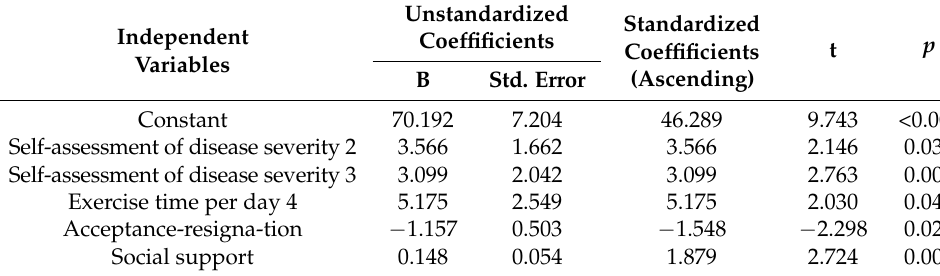
Table 5. The multiple linear regression results of BF (N = 319).